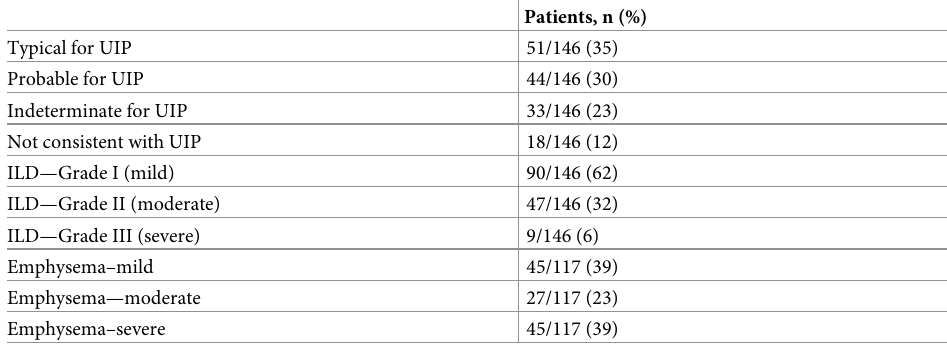
Table 3. Classification and extent of ILD and extent of emphysema on CT in the study